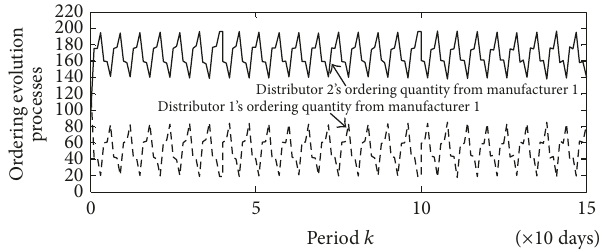
Figure 9: Inventory evolution processes under the fuzzy robust strategy ( ×10 4 ton).